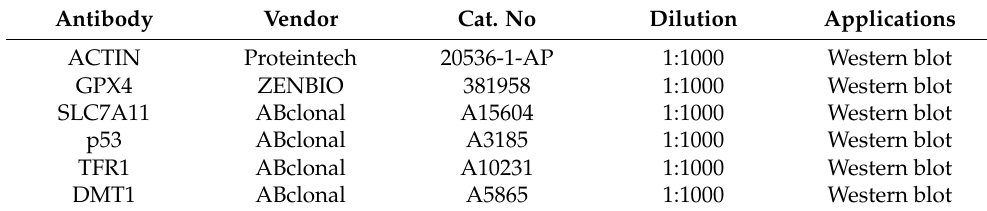
Table 2. Primary antibodies.